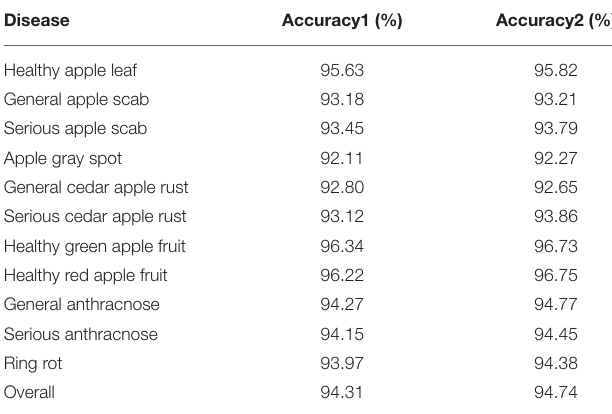
TABLE 4 | The diagnosis results of two models for different